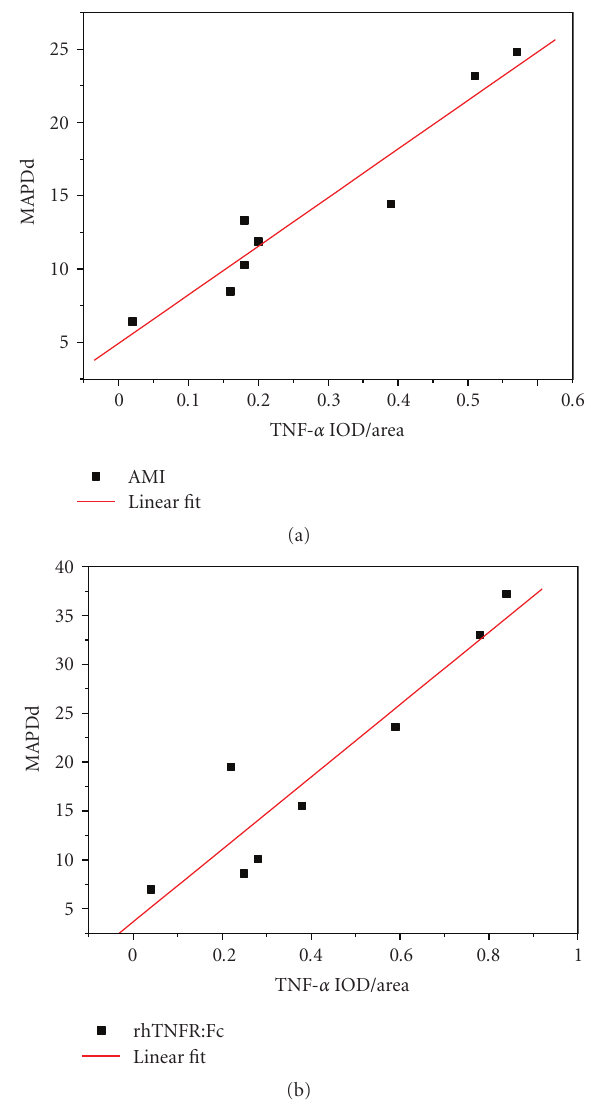
Figure 8: The correlation between TNF- α expression and MAPDds in the border